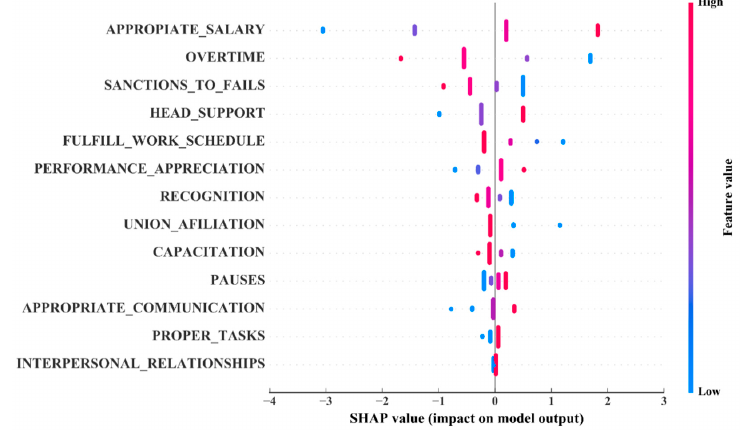
Figure 1. SHAP summary plot for the Linear SVM model trained using only risk factors of burnout.